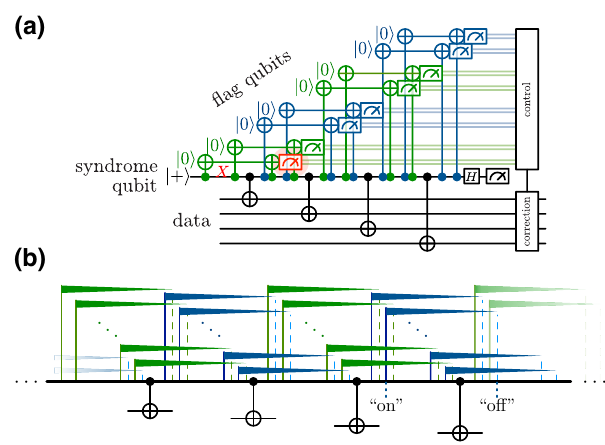
FIG. 2. (a) Distance-three fault-tolerant measurement of X ⊗ 4 . Each controlled- NOT ( CNOT ) gate to the data is protected by two flags. X corrections are applied based on the flag pattern. (b) Schematic showing how the circuit extends to X ⊗ w and arbi- trary distance d ; control and corrections are omitted. Between each consecutive pair of CNOT gates to the data, 2 t flags are turned on, and 2 t turned off, in an alternating fashion: on, off, on, off.